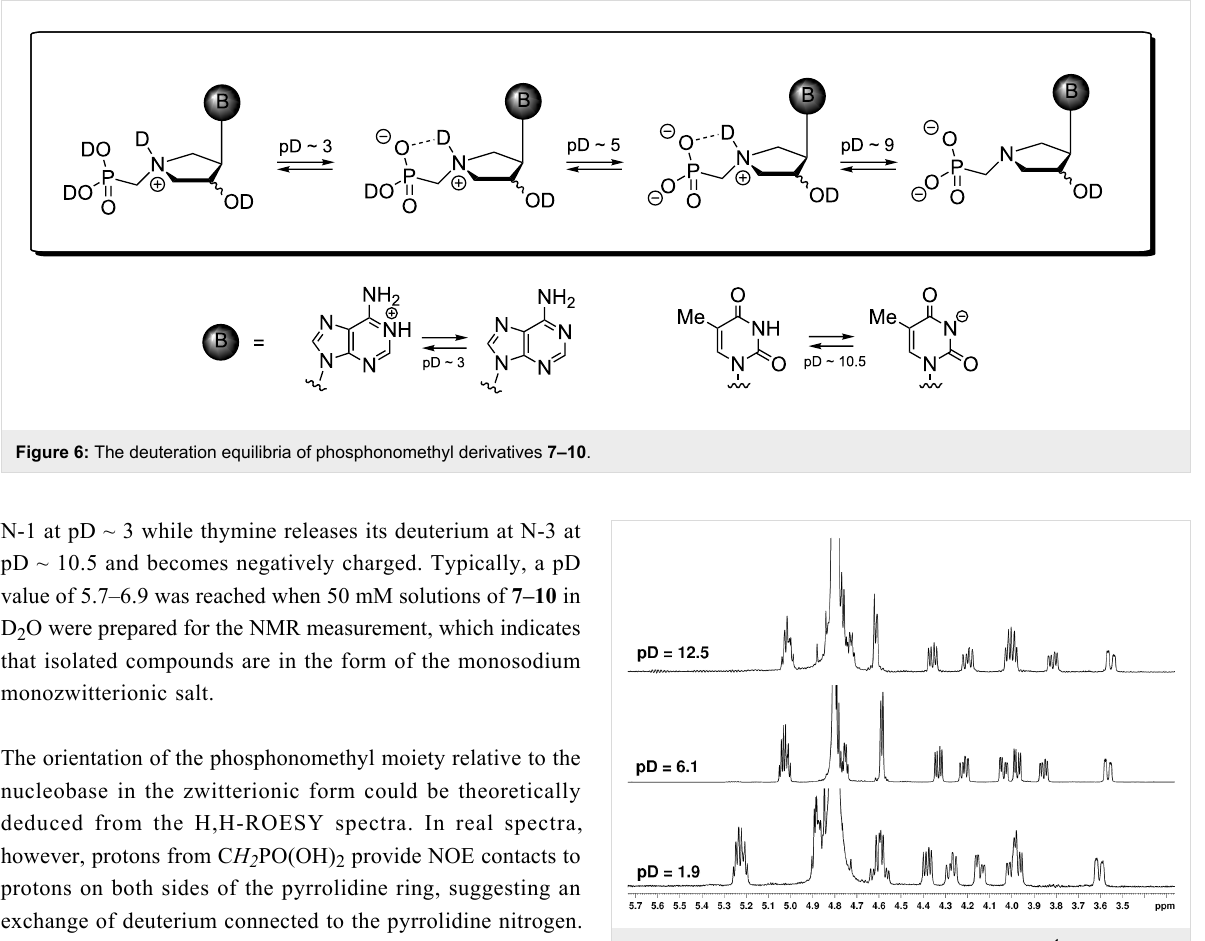
Figure 7: The aliphatic part (pyrrolidine protons) of the 1 H NMR spectra of 13 measured in D 2 O at different pD values.